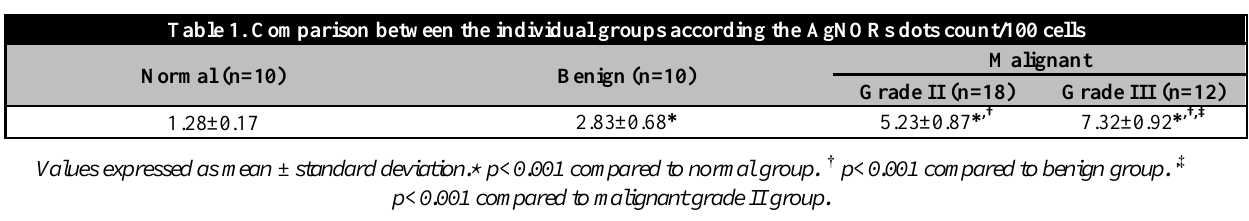
Table 1. Comparison between the individual groups according the AgNORs dots count/100 cells Normal (n=10)